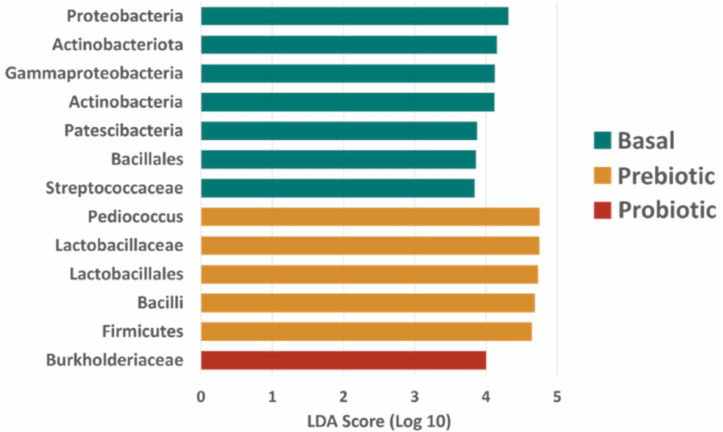
Figure 5. Results of differential taxa abundance testing from Linear Discriminant Analysis (LDA) Effect Size (LEfSe). Taxa shown were found to have significantly higher relative abundance in the specified group relative to all other groups with an LDA Score (log 10) > 3.0 and p <